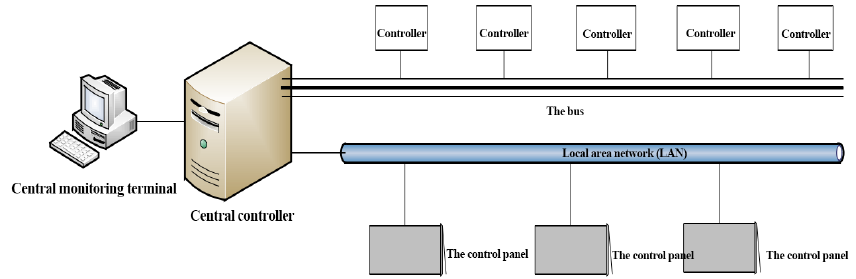
Figure 1. The structure of the centralized lighting control system.